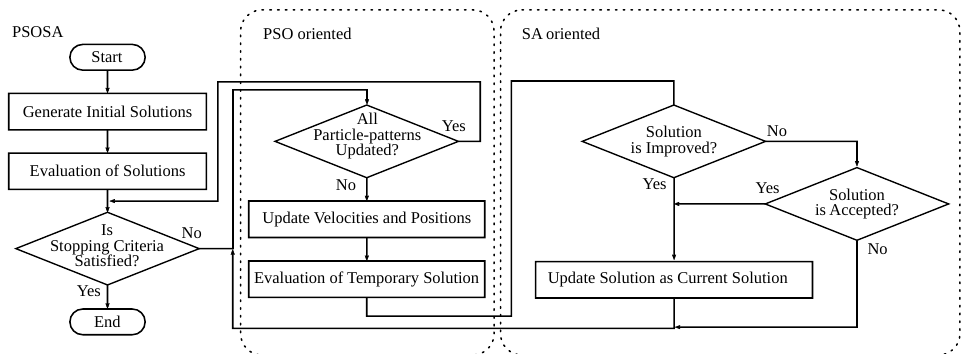
Figure 2. Flowchart of